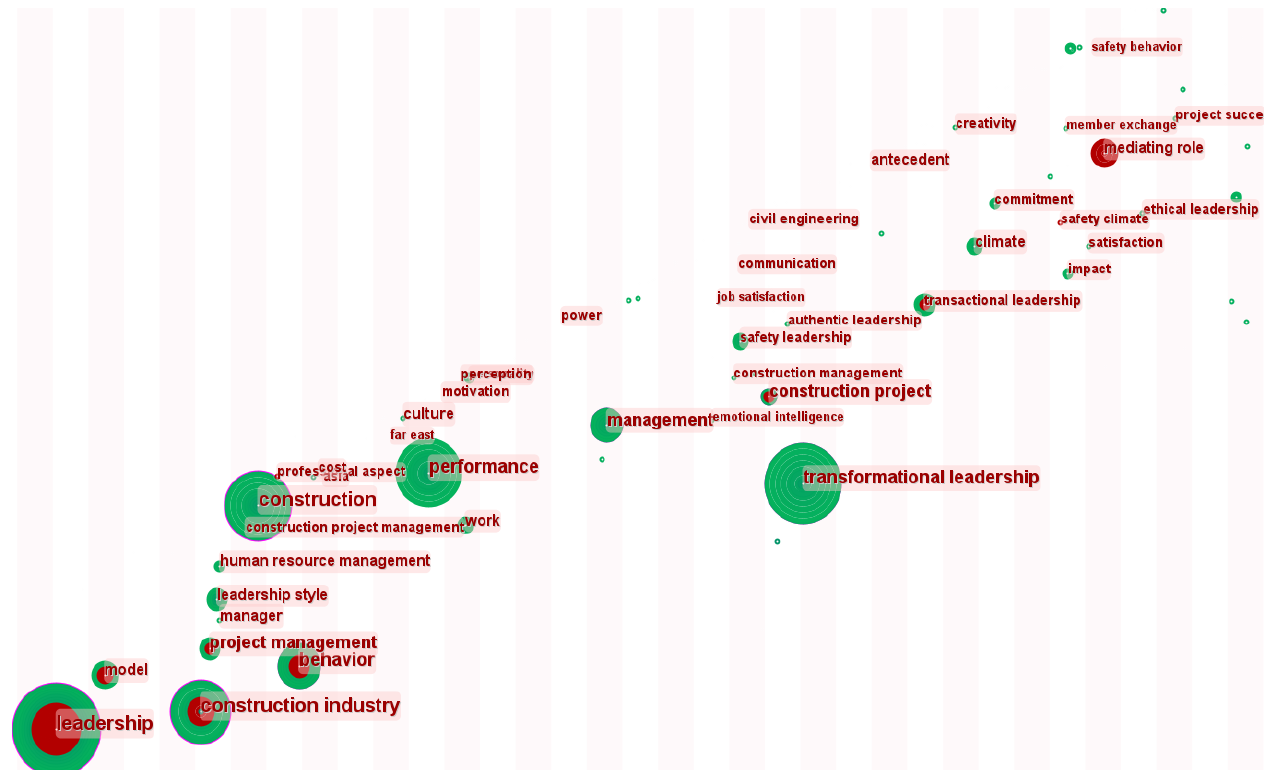
currence Frequency